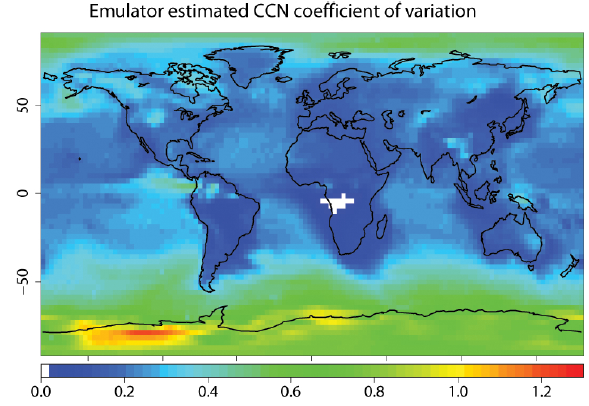
/µ CCN for grid- ij ij